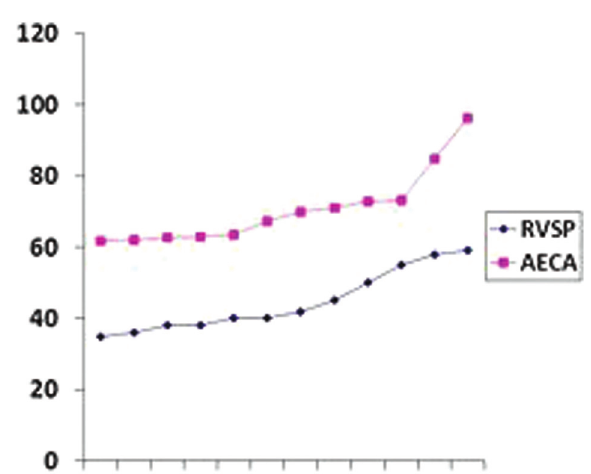
Correlation of AECA levels (ng/ml) and RVSP (mmHg) in COPD patients with cor pulmonale. Pearson correlation ( r = 0.913; P = 0.001). AECA, antiendothelial cell antibody; COPD, chronic obstructive pul- monary disease; RVSP, right ventricular systolic